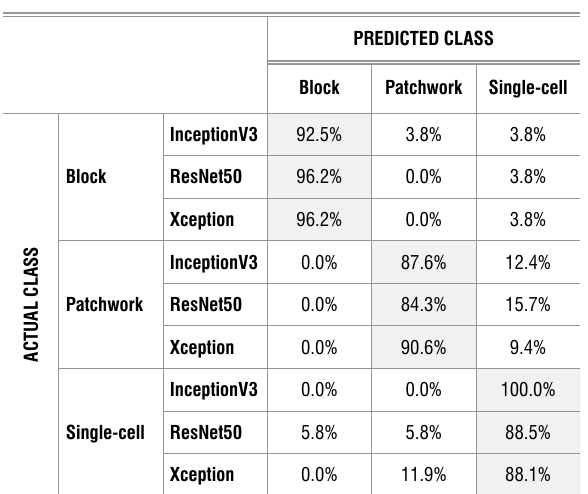
Confusion matrix for the classification task using the VAE- augmented data set. Table cells highlighted in grey indicate correctly classified images.